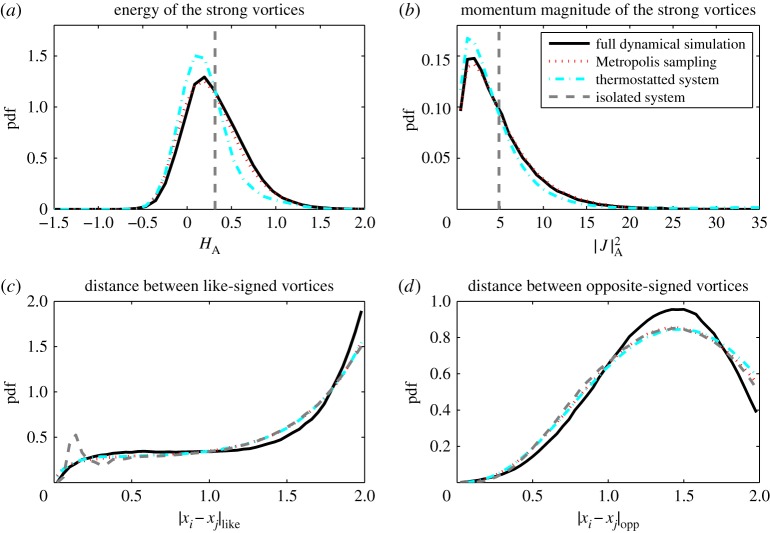
Histograms for Hfull≈2. Panel layouts same as figure 1. (Online version in colour.)